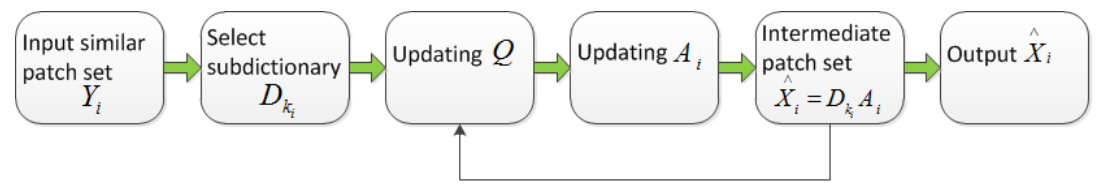
Figure 1. The pipeline of our proposed